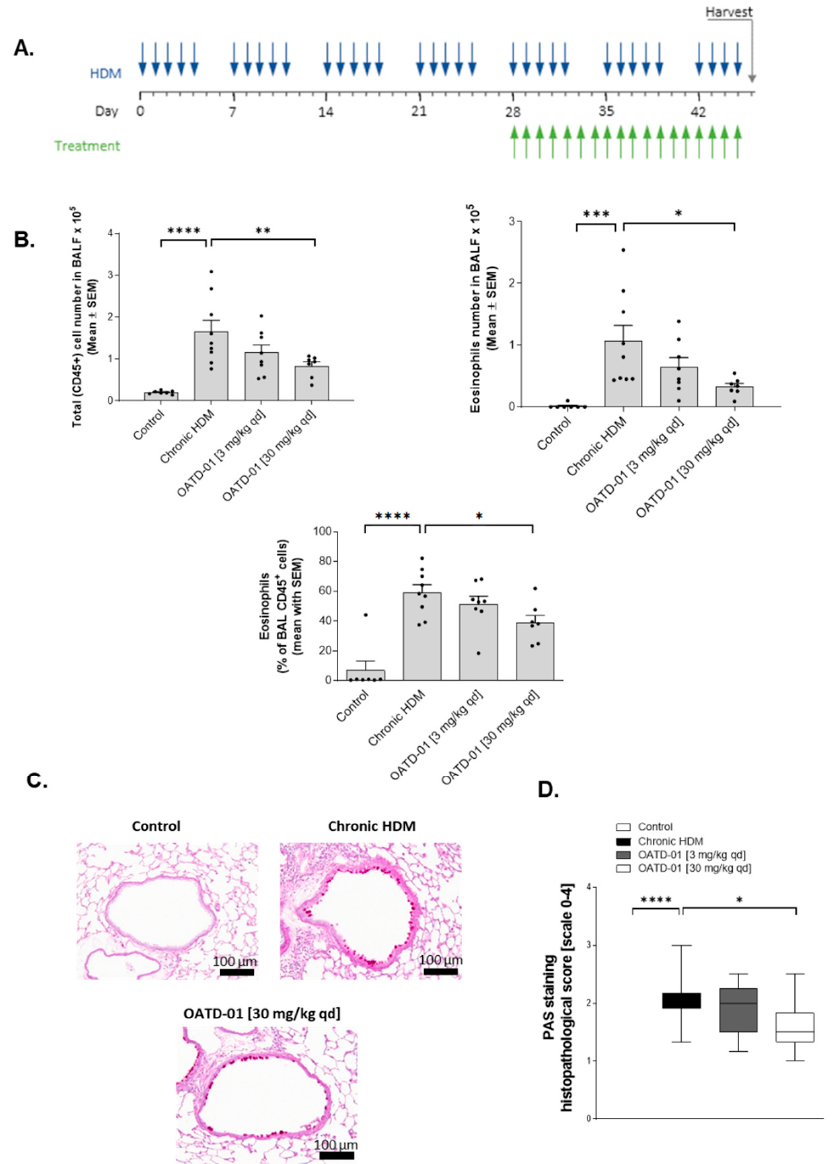
Figure 3. OATD-01 reduces goblet cell metaplasia and exhibits anti-inflammatory effects in chronic HDM-induced model. ( A ) Schematic representation of HDM model and OATD-01 administration regimen. Blue arrows indicated HDM installations while green OATD-01 treatment. ( B ) Flow cytometry analysis of pulmonary inflammation as represented by total leukocyte numbers (CD45+ cells) and eosinophil population (Siglec F+, CD11c- cells) in particular, in BAL fluid of mice subjected to chronic HDM (7 weeks) and treated with OATD-01 (3 and 30 mg/kg; PO; qd) or vehicle controls. ( C ) Representative PAS staining of goblet cell metaplasia in chronic HDM-induced airway remodeling model. ( D ) Semi-quantitative analysis of goblet cell metaplasia by scoring system (0–4) in the lung sections of chronic HDM administration model as compared to vehicle treated controls. Data presented as mean ± s.e.m. p -values < 0.05 were considered as statistically significant and presented as * for p < 0.05, ** for p < 0.01, *** for p < 0.001, and **** for p <